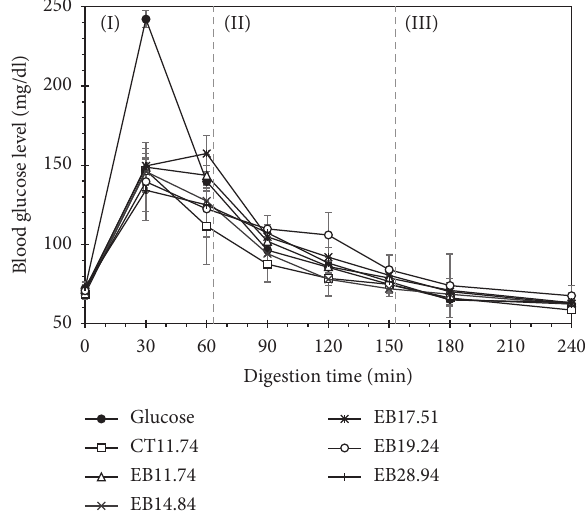
Figure 5: Blood glucose levels in mice after feeding glucose and starch